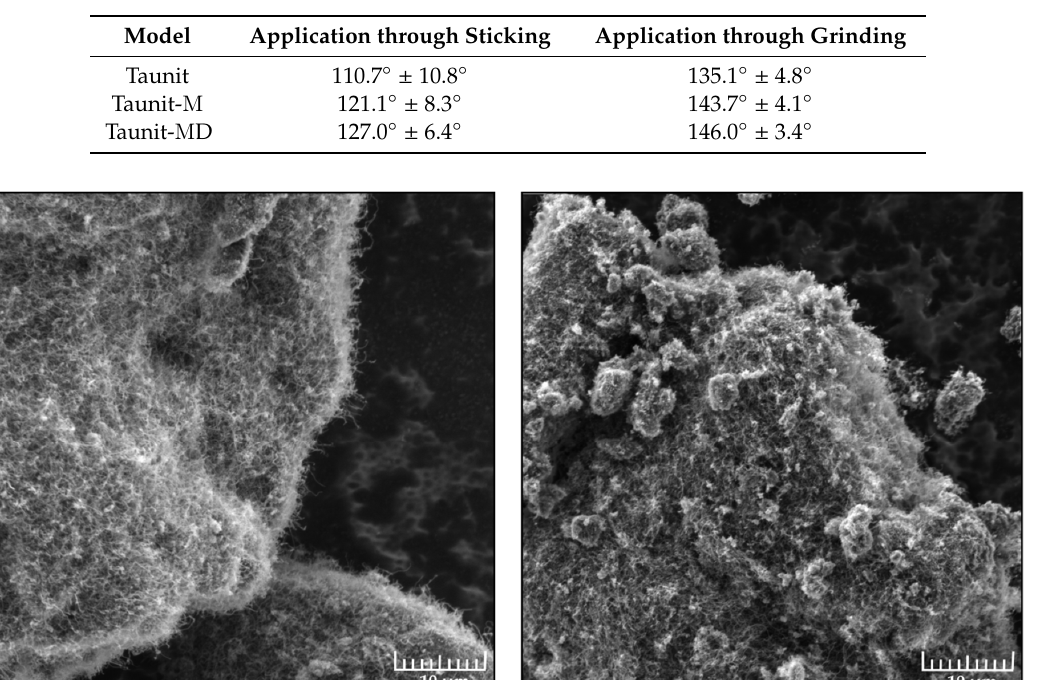
Figure 3. Hydrophobic coating based on Taunit CNT agglomerates. Left side shows application through sticking, right side demonstrates application through grinding. The image was obtained through a Tescan Vega 3 scanning electron microscope.